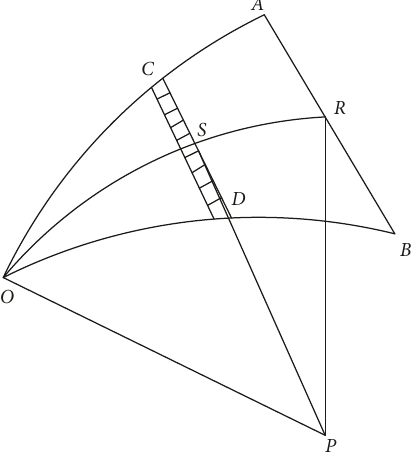
Figure 9: Warped triangular